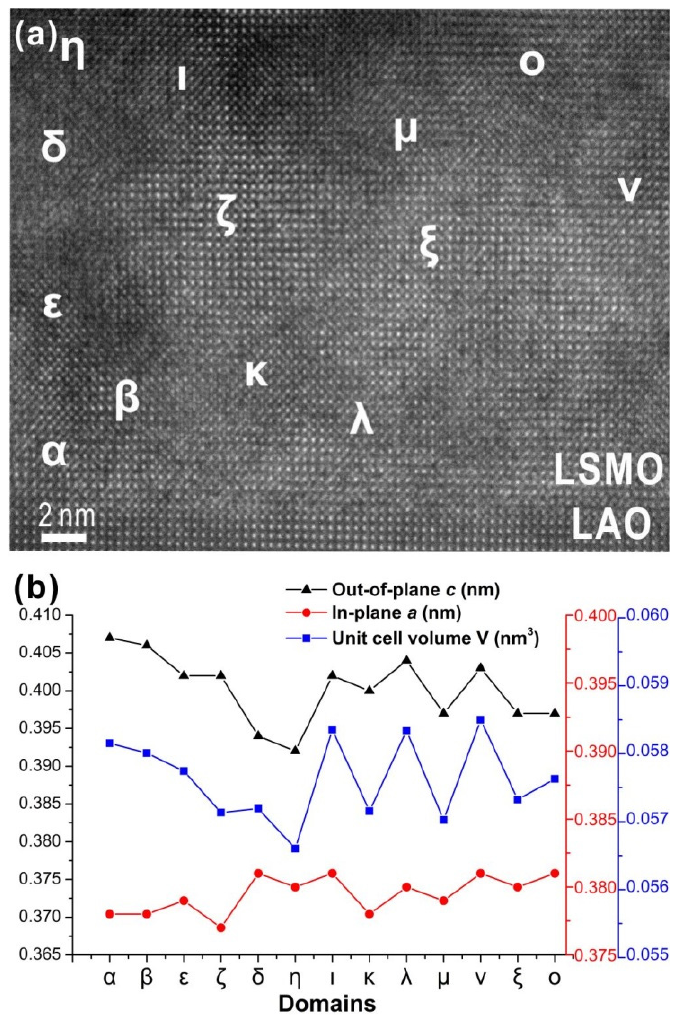
Figure 6. ( a ) High magnitude of cross-section HRTEM image of the interface between the ECG thin film and the substrate; ( b ) Out-of-plane, in-plane lattice parameters and corresponding unit cell volume measured from the different sites in